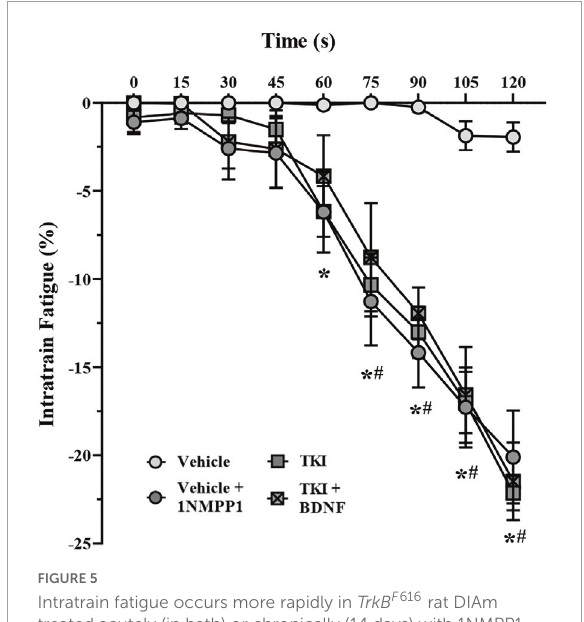
FIGURE5 Intratrain fatigue occurs more rapidly in TrkB F 616 rat DIAm treated acutely (in bath) or chronically (14 days) with 1NMPP1. Plot (mean ± SEM) of time course of intratrain faatigue illustrating increased failure of vehicle + 1NMPP1 (denoted by # ), TKI (denoted by *), and TKI + BDNF (denoted by # ) compared to vehicle rats (two-way ANOVA, Bonferroni post-tests). N = 8 rats per group. In all cases * # P < 0.05, compared to